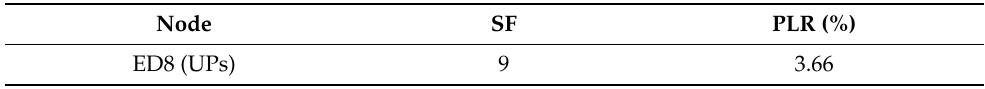
Table 5. Analysis of PLR in UL due to DL